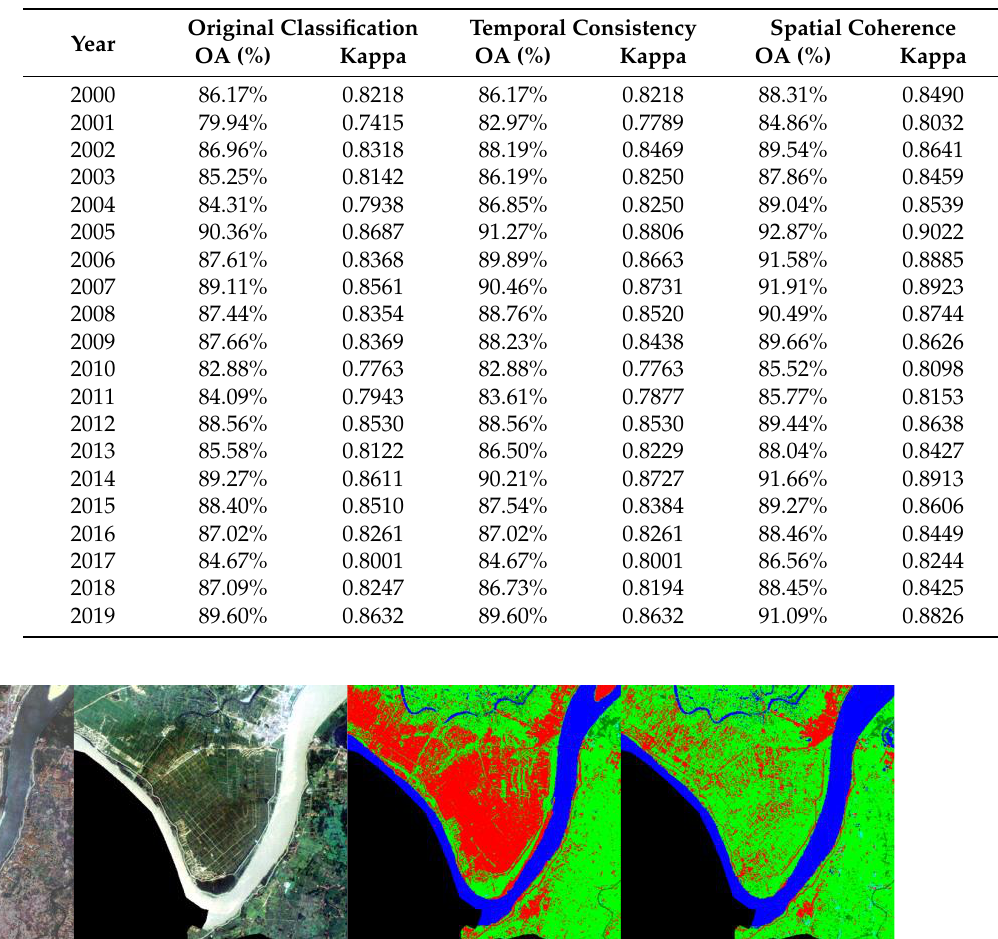
Table 3. Accuracy assessment of the LULC maps of Wuhan during the period 2000–2019.